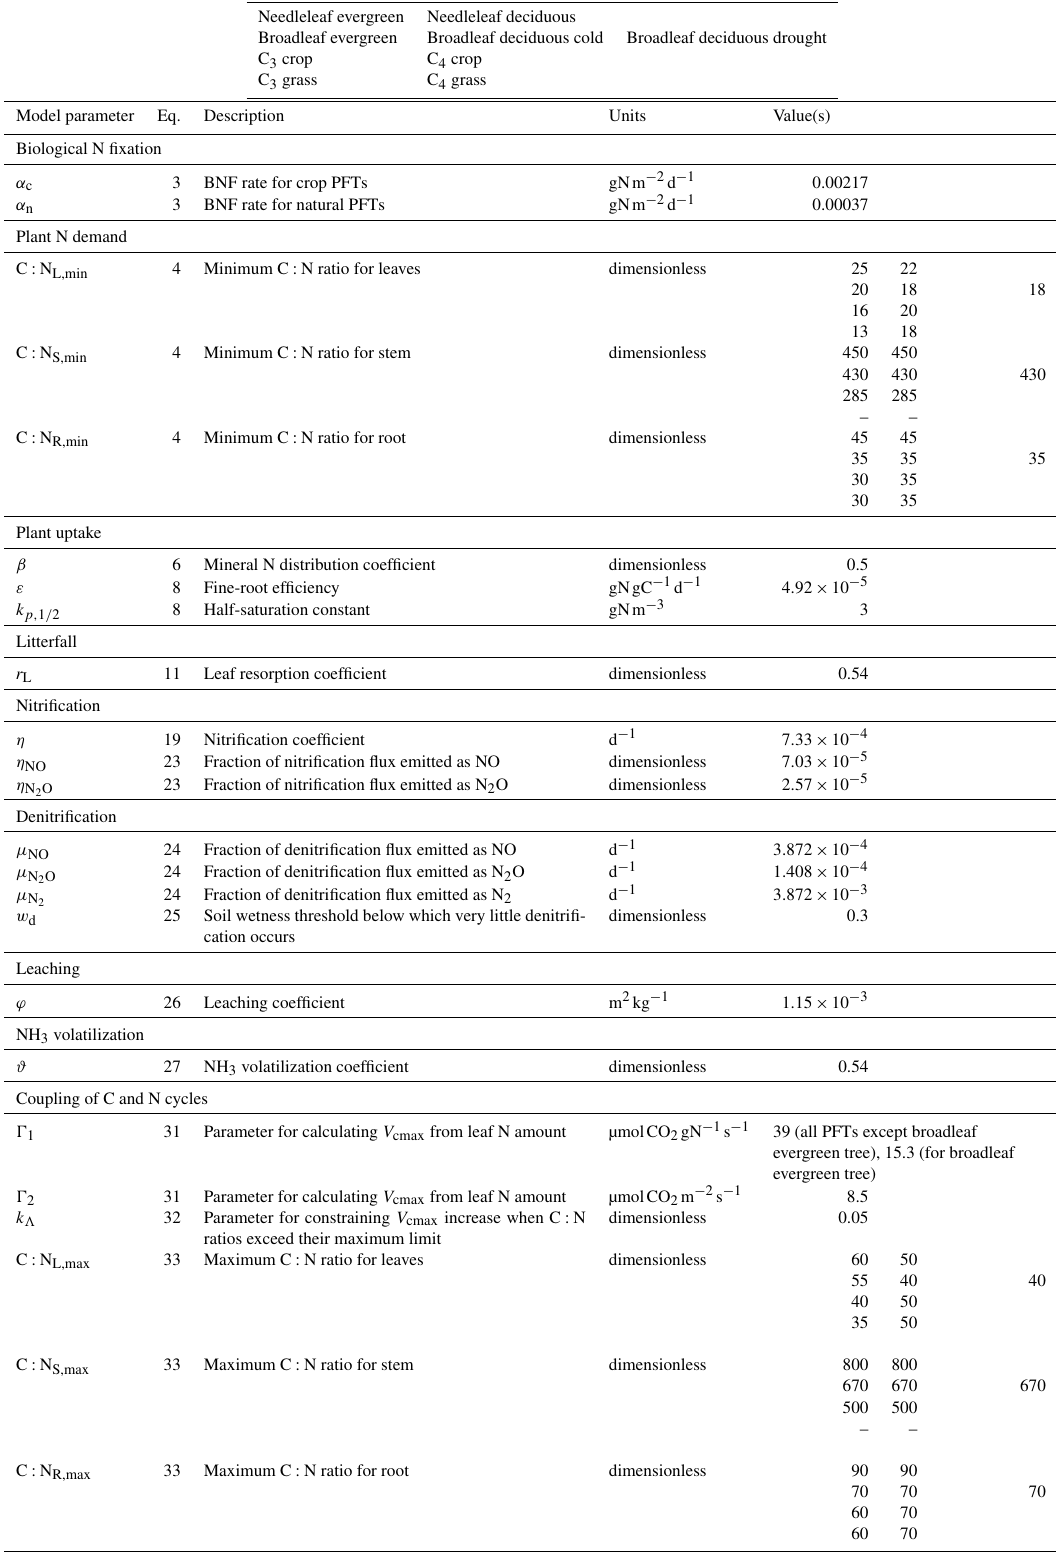
Table A1. Model parameters for various model parameterizations. The corresponding equation in which the parameter appears in the main text is also noted. Model parameters may be scalar or an array (if they are PFT dependent) in which case they are written according to the following structure in the table